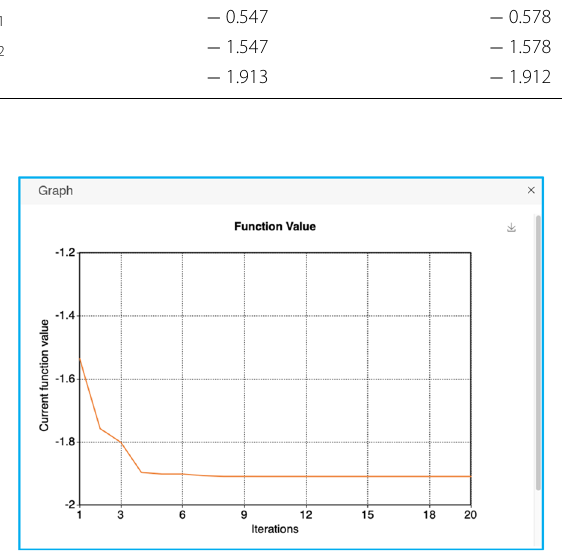
Figure 18 The iteration plot of the GA block